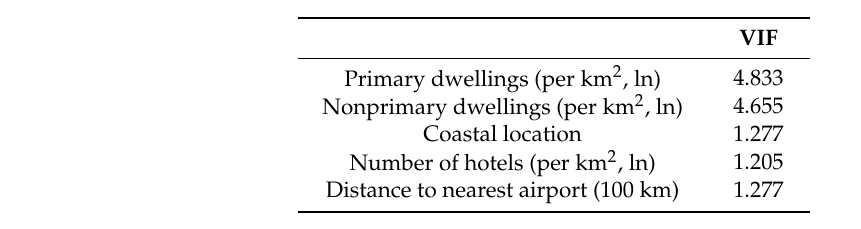
Table A6. Variance inflation factors for linear models for municipalities (N = 8124).